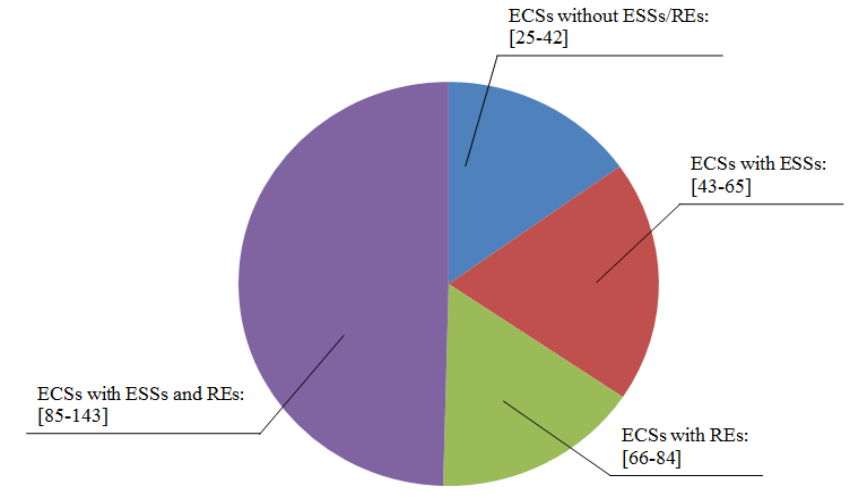
Figure 2. Categories of reviewed papers according to electric vehicle charging stations (ECS) configurations.